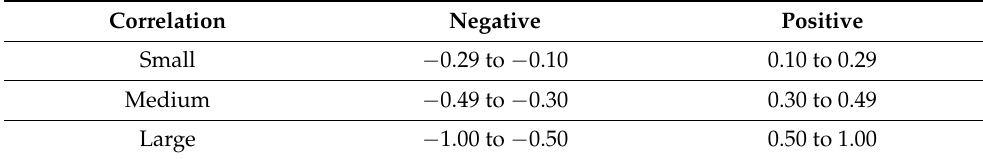
Table 4. General Correlation